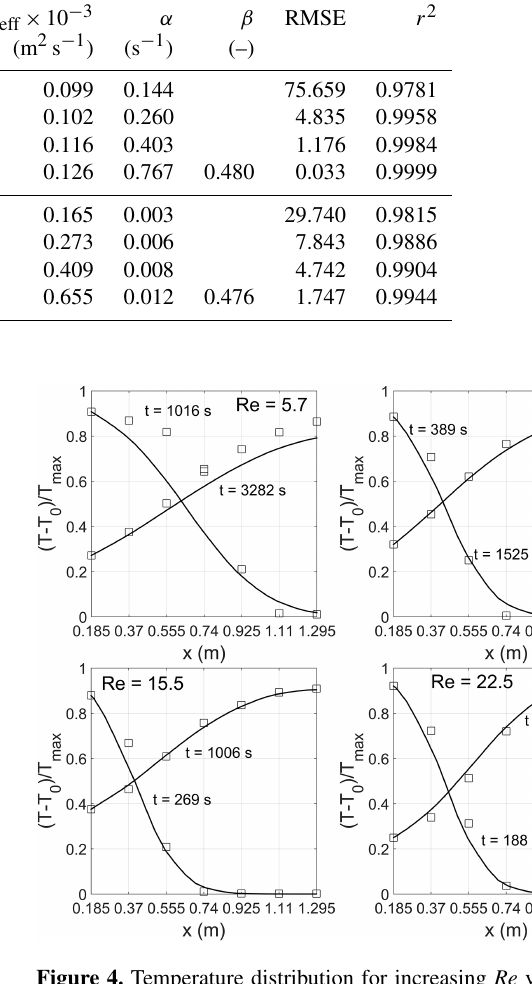
Figure 4. Temperature distribution for increasing Re values along the porous column filled with material M 2 . The two curves repre- sent the inlet and the downstream temperature. Squares represent the experimental values, continuous lines represent the simulated